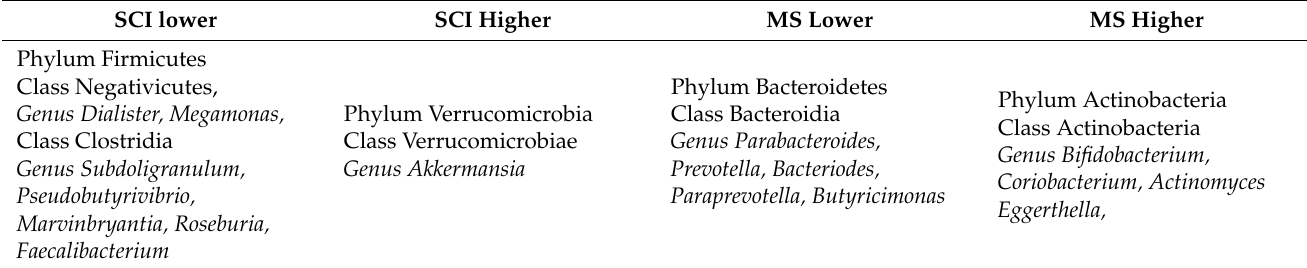
Table A4. Taxonomic outcomes per